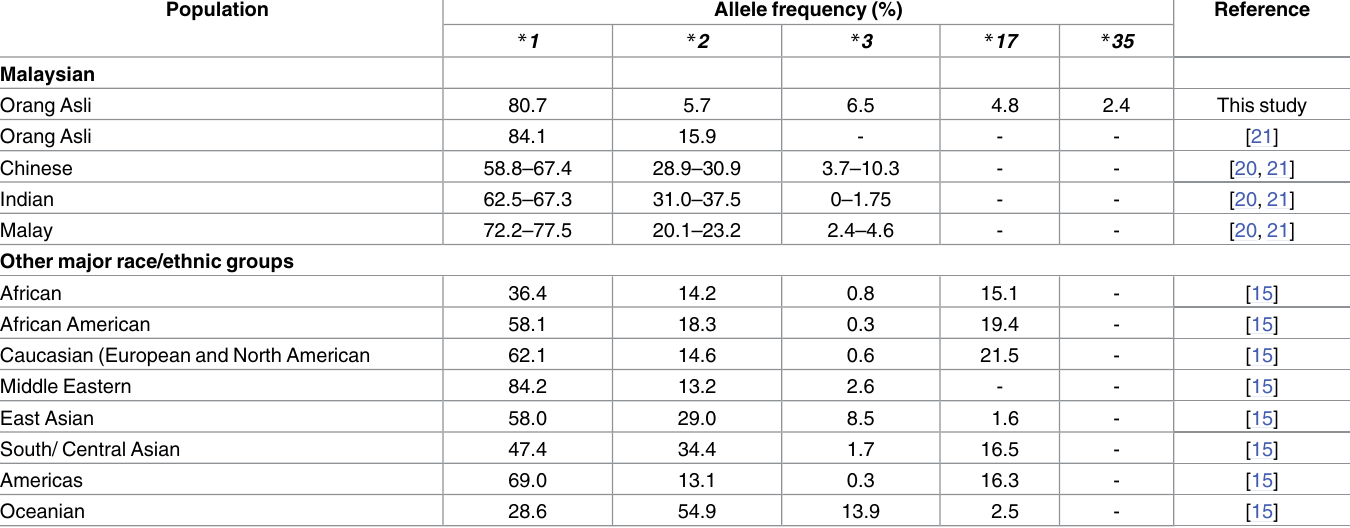
Table 4. Comparison of CYP2C19 allele frequencies between the Orang Asli and various